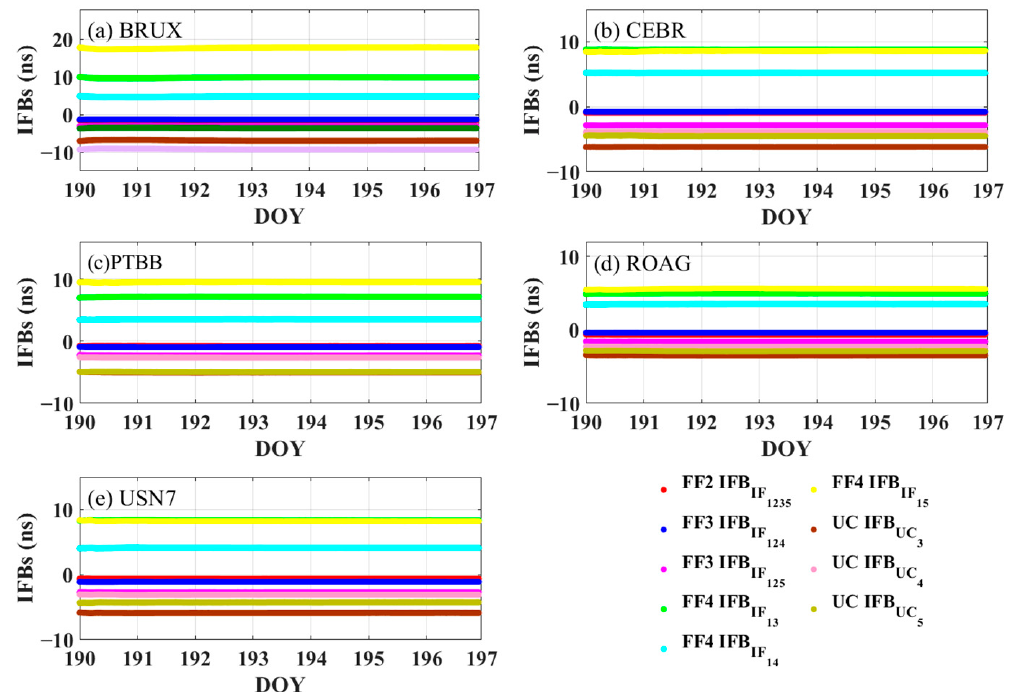
Figure 11. IFB sequences at five stations for the FF2, FF3, FF4 and UC PPP models on DOYs 190 to 196 in 2020. ( a ) BRUX station; ( b ) CEBR station; ( c ) PTBB station; ( d ) ROAG station; and ( e ) USN7 station.